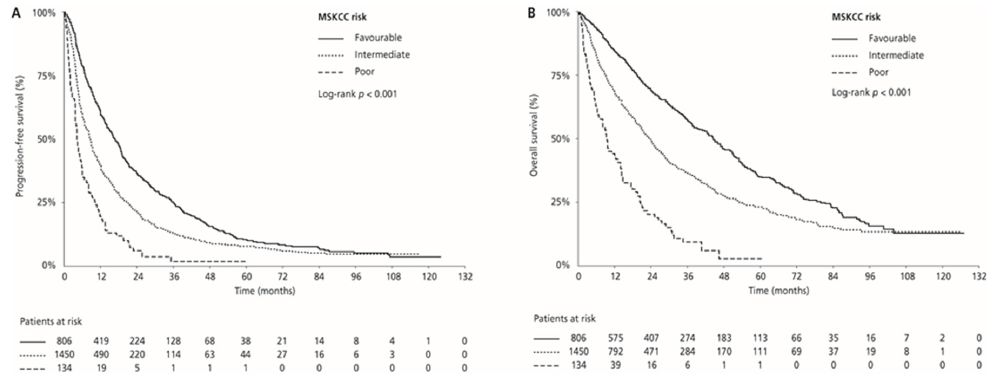
† Complete response + partial response together, CI = confidence interval, MSKCC = Memorial Sloan– 171 Figure 3. Kaplan–Meier estimates of progression-free survival (PFS) ( A ) and overall survival (OS) Kettering Cancer Center (MSKCC) score, OS = overall survival, PFS = progression-free survival, n = 172 Figure 3. Kaplan–Meier estimates of progression-free survival (PFS) and overall survival (OS) 167 ( B ) according to the MSKCC risk category. number of included patients. 173 according to the MSKCC risk category. 168 Table 2. Overall response rate (ORR), overall survival (OS), and progression-free survival (PFS) 169 results for sunitinib treatment according to MSKCC risk groups. 170